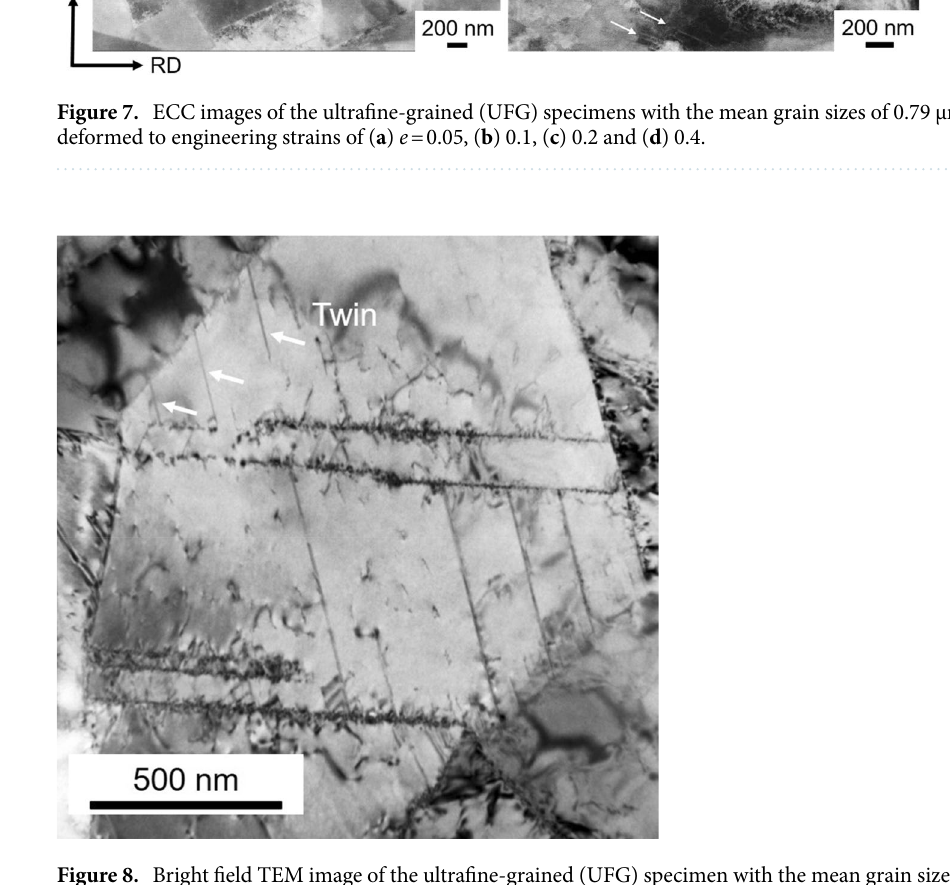
also connected their ends to grain boundaries (Figs. 5 and 6). In our parallel study, deformed microstructures of the present high-Mn steel were carefully examined by transmission electron microscope (TEM) 49 . Figure 8 showed a representative bright field TEM image of the UFG specimen with the grain size of 0.79 μm after a tensile deformation to a strain of 0.062. It was clearly seen that several deformation twins (indicated by white arrows) generated from grain boundaries, which was consistent with the result of the ECC image shown in Fig. 7(b). The detailed characterization of microstructures is discussed in our another paper 49 . At strains of 0.2 and 0.4 (Fig. 7c